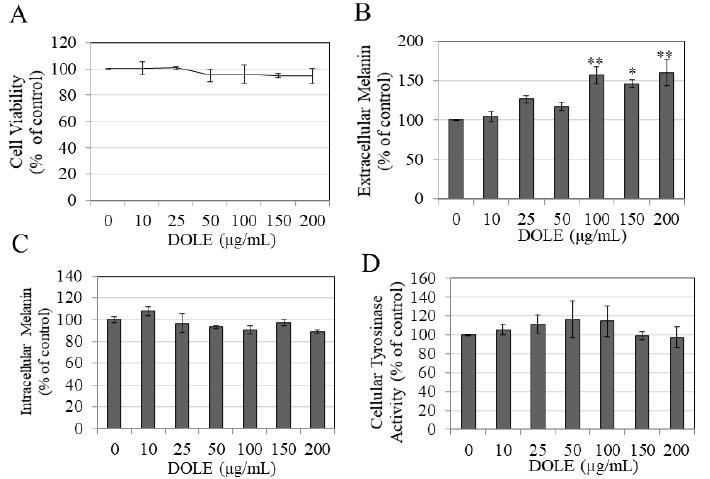
Figure 1. ( A ) Viability of B16F10 mouse melanoma cells treated with dry olive leaf extract (DOLE) over a concentration range (0–200 µg/mL) for a period of 48 h; data are mean ± SEM of three independent experiments. ( B ) Extracellular melanin and ( C ) intracellular melanin levels in B16F10 cell cultures treated for 48 h with different concentrations of DOLE; ( D ) effects of DOLE on cellular tyrosinase activity in B16F10 cells quantitated as melanin formation from L-DOPA; data for ( B – D ) are mean ± SEM of at least two independent experiments; * p < 0.05 vs. control, ** p < 0.01 vs. control; one-way ANOVA with Dunnett’s post hoc test.